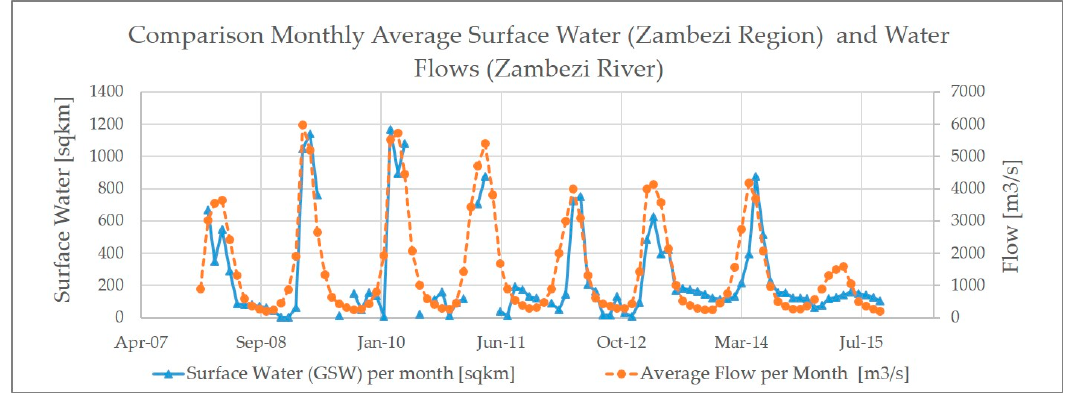
Figure 9. Average monthly surface water and flow at Zambezi Region and River.